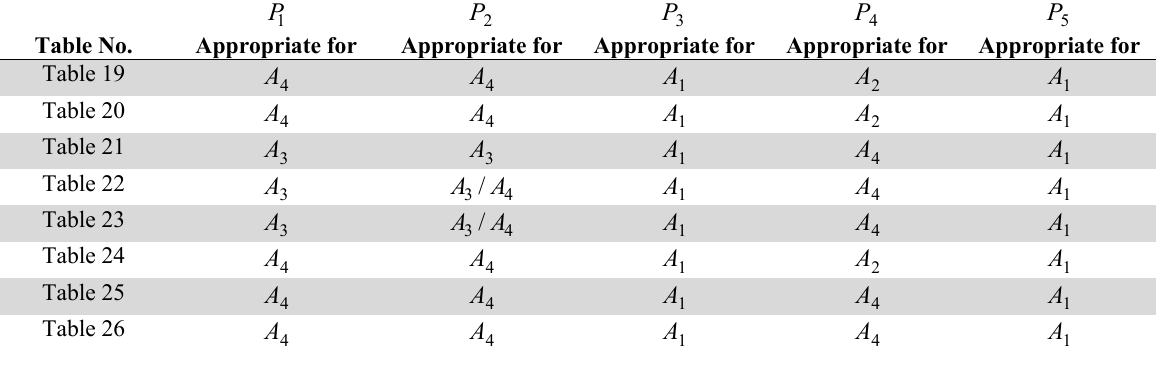
A 4 A 4 A 3 A 3 A 3 A 4 A 4 A 4